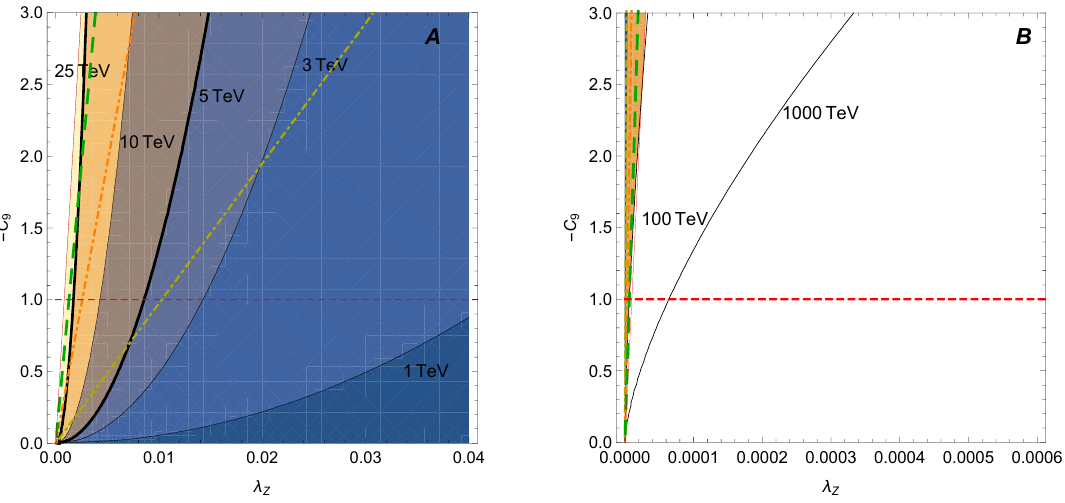
Figure 5 . Estimated (maximal) NP mass M max in dependence on the triple-gauge coupling ( (cid:21) Z ) and the coe(cid:14)cient of the four fermion operator O 9 ( C 9 ) in Scenario A (left) and B (right). The colored lines denote NP couplings of g (cid:3) = 1 ; 4 ; 8 ; 4 (cid:25) , respectively (from yellow to red), and the horizontal dashed line depicts the currently preferred value of C 9 (cid:24) (cid:0) 1. See text for